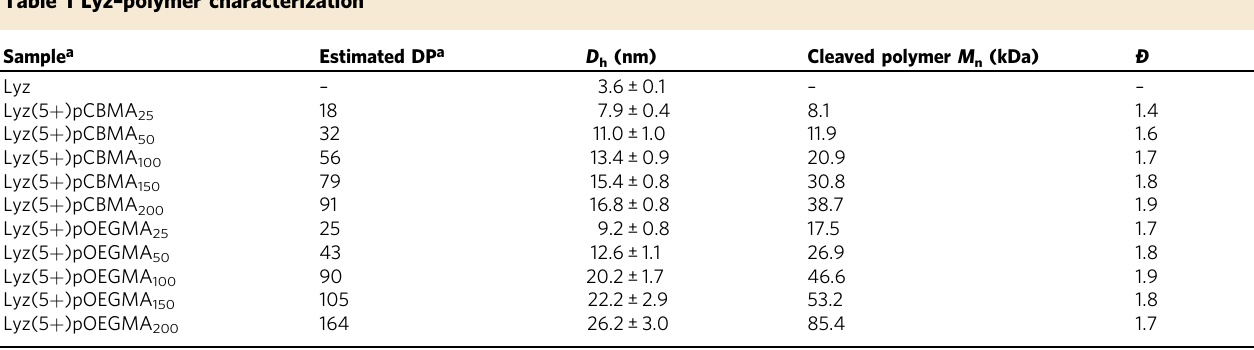
Table 1 Lyz – polymer characterization Sample